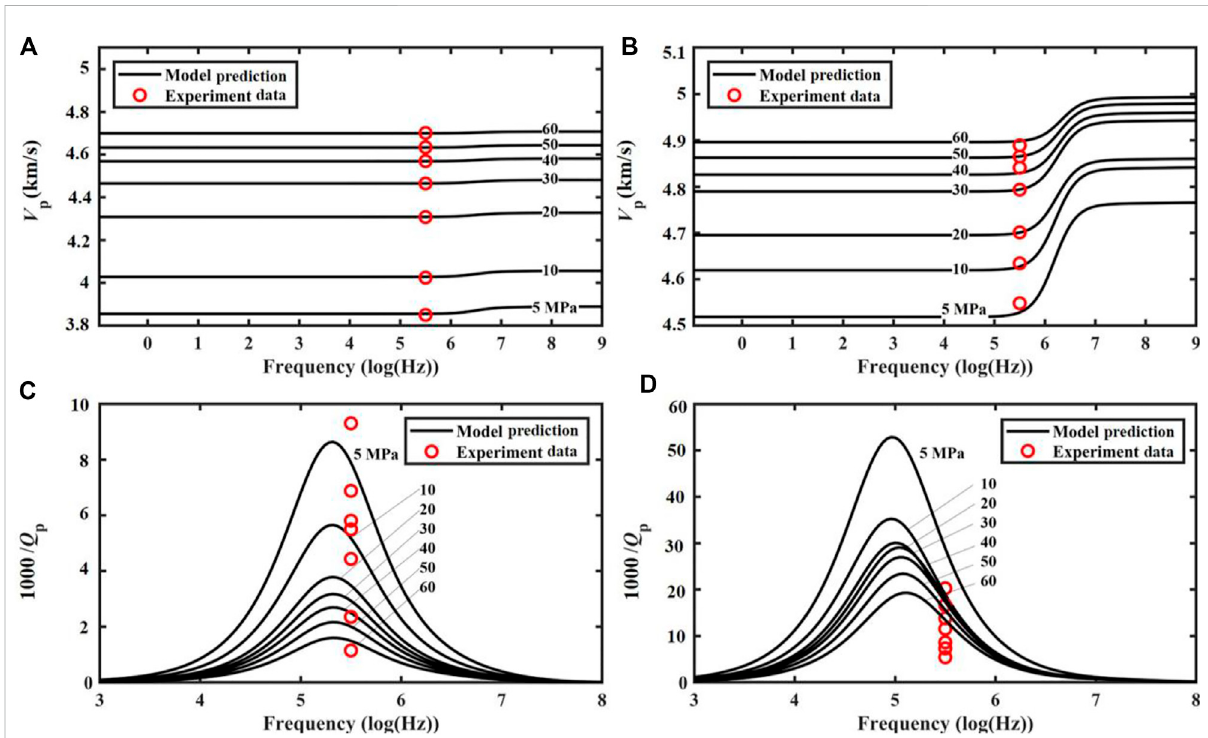
FIGURE 9 P-wave velocity frequency dependency for the gas- (A) and water- (B) saturated sample 1 – 19 at different con fi ning pressures. The P-wave dissipation factors are shown in panels (C,D) , respectively, for gas and water. The experimental data are shown as red